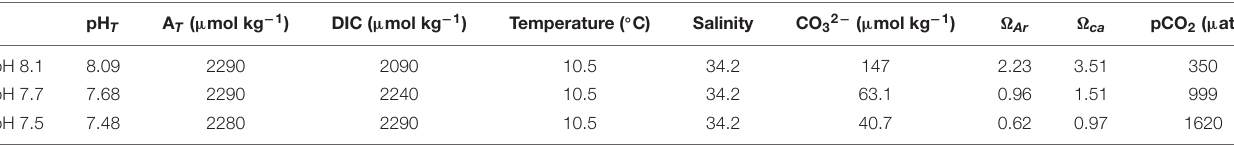
FIGURE 1 | Image taken with a compound microscope of a juvenile sea urchin Pseudechinus huttoni 4 days post-settlement. Morphometric measurements are spine length (average of three longest spines or SL) and test diameter (average of two longest diameters or TD). Scale bar 200 µ m. TABLE 1 | Average seawater carbonate chemistry parameters in bulk seawater samples.